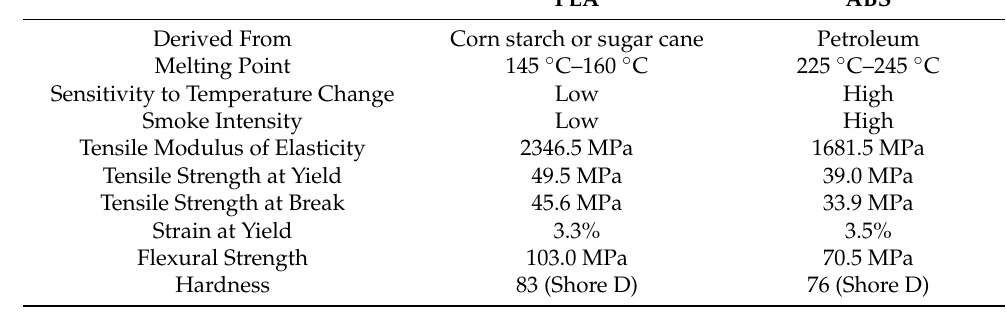
Table 2. 3D Printing Materials Comparison.